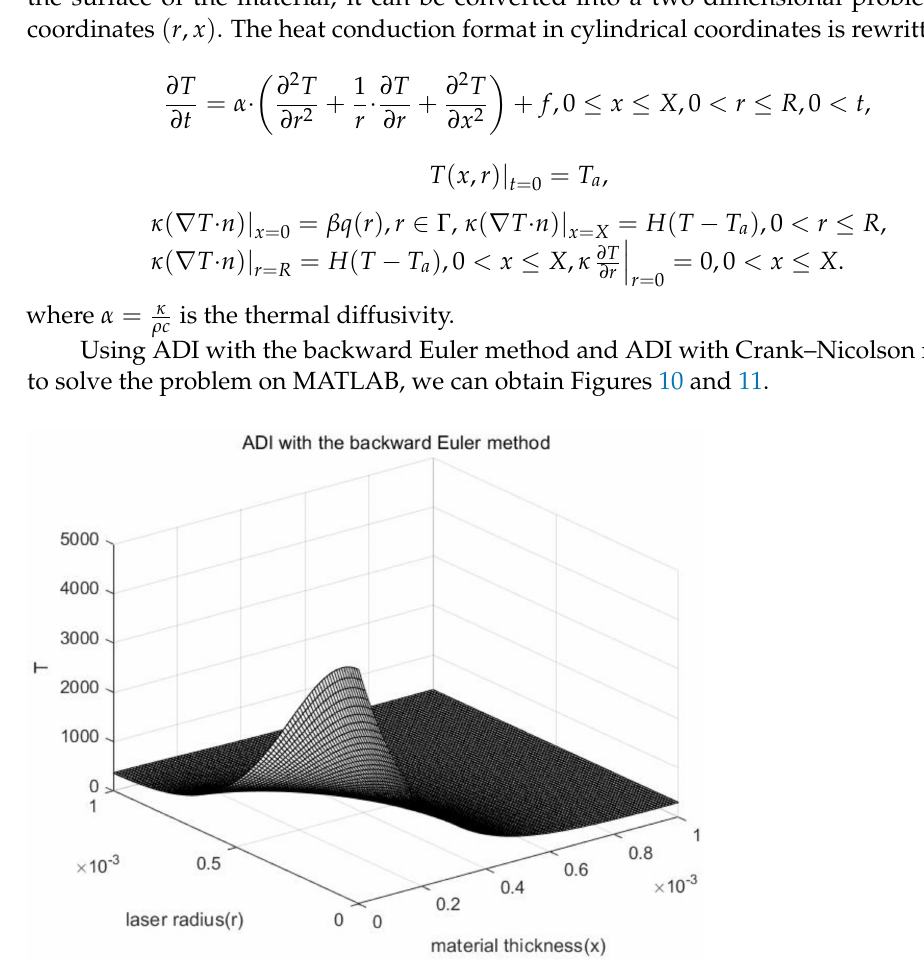
Figure 10. Numerical solutions of difference equations ( h = 0.001 / 100, τ = 0.01 / 1000, H = 1.5 ) .